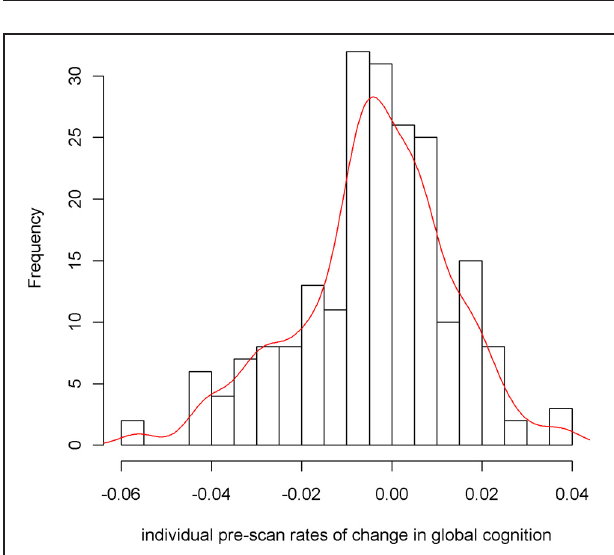
FIGURE 2 | Distribution of person-specific pre-scan rates of decline.